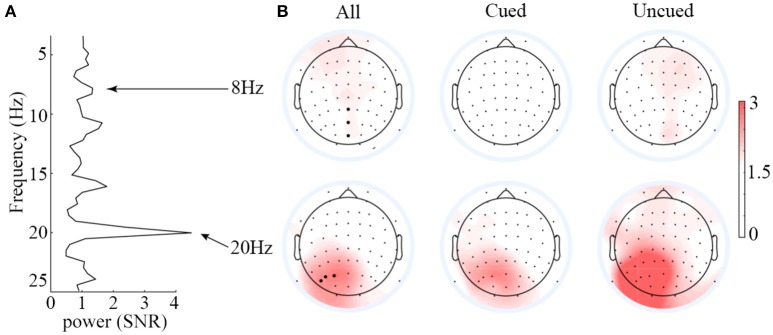
Averaged SNR spectrum of the PO3, PO5, and PO7 electrodes (A) and scalp topographies of the SSVEPs elicited by 8 and 20 Hz flickers (B). Overall, the SNR of 8-Hz-flicker-elicited SSVEPs was very low, and it is hard to differentiate the signal from noise; the SNR of 20-Hz-flicker-elicited SSVEPs was relatively higher over the left occipitoparietal scalp.